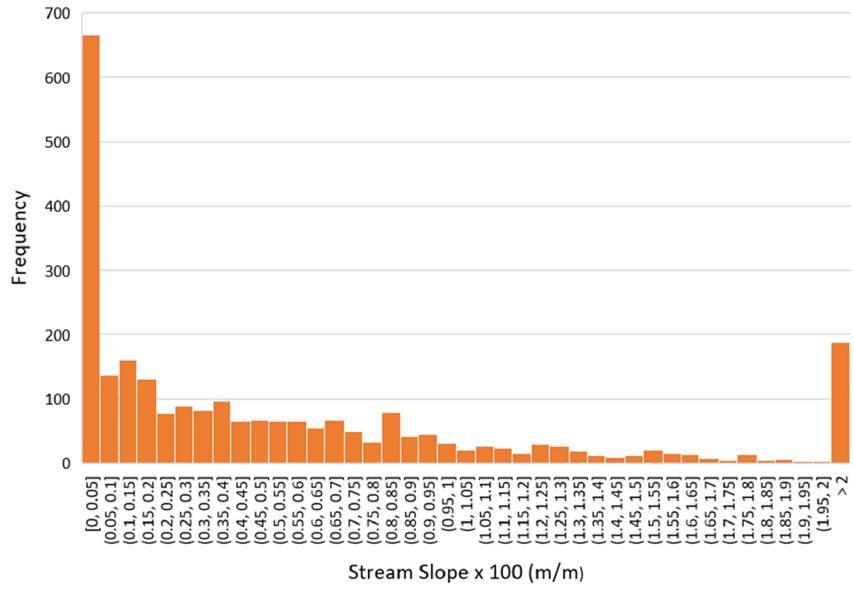
Figure 8. Stream slope at low head dams in sample states with no fatalities recorded.